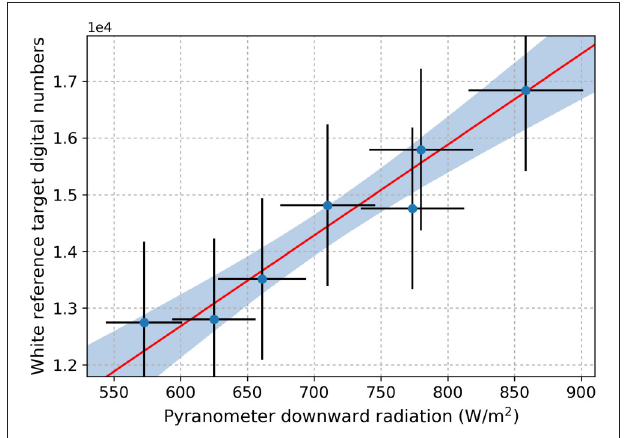
FIGURE 3 | The relationship between the downward radiation measured by a broadband pyranometer and the digital numbers of a white reference